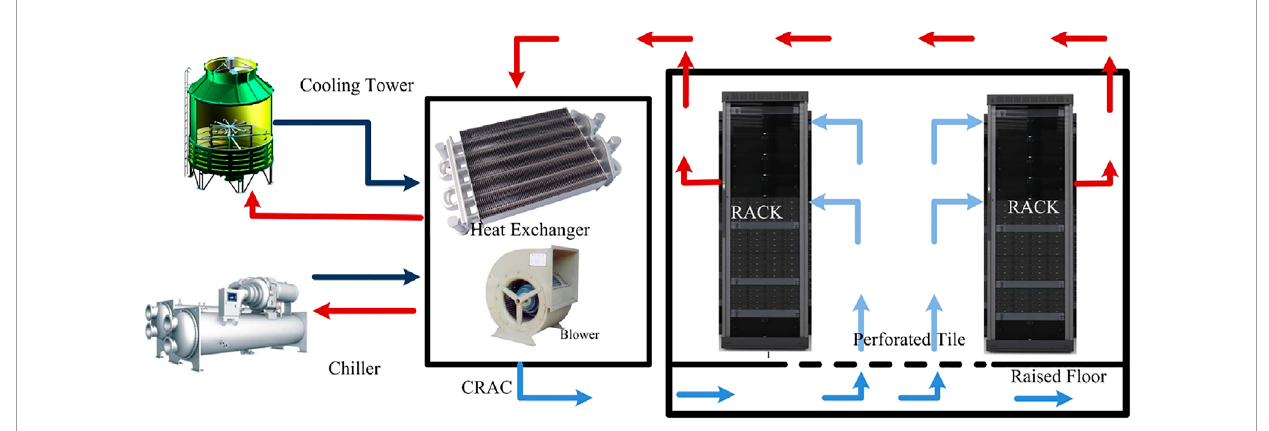
FIGURE 1 A typical raised-floor data center model with the heat-exchange process.